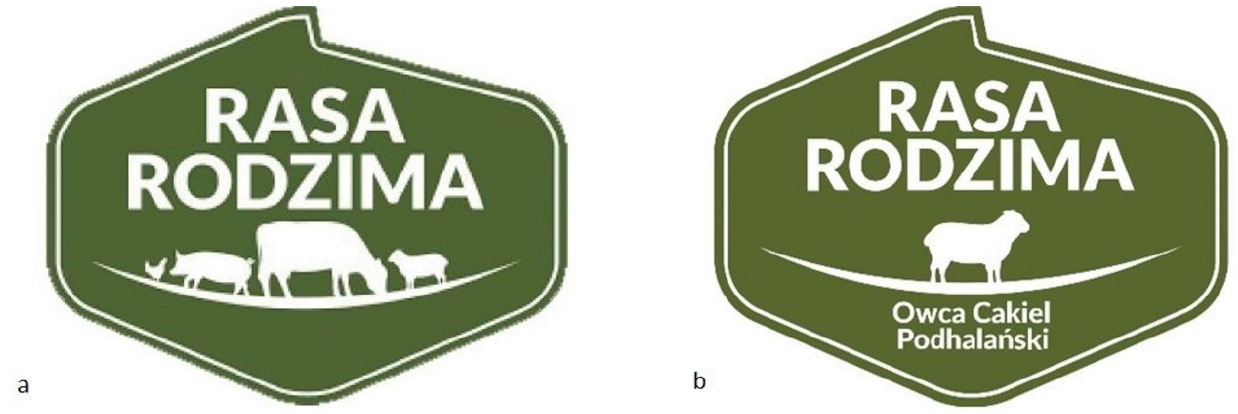
Figure 5. The NRIAP certification logo for Native Breed ( a ) and Native Breed—Podhale Zackel ( b ). The logo system is not a quality system as defined by EU regulations, but it meets similar requirements. It is expected that the logo will promote the products of specific Polish native breeds kept under traditional (natural) systems on local markets. The main purpose of using the logo for producers of native breeds is to promote and raise public awareness of the role and importance of native breeds as an important part of our national heritage. This promotion is intended to highlight the importance of Polish native breeds, their historical as well as social and cultural value, the role they play in environmental and landscape renewal, and the potentials represented by their genetic resources. The logo is also intended to indicate products having a higher nutritional and health-promoting